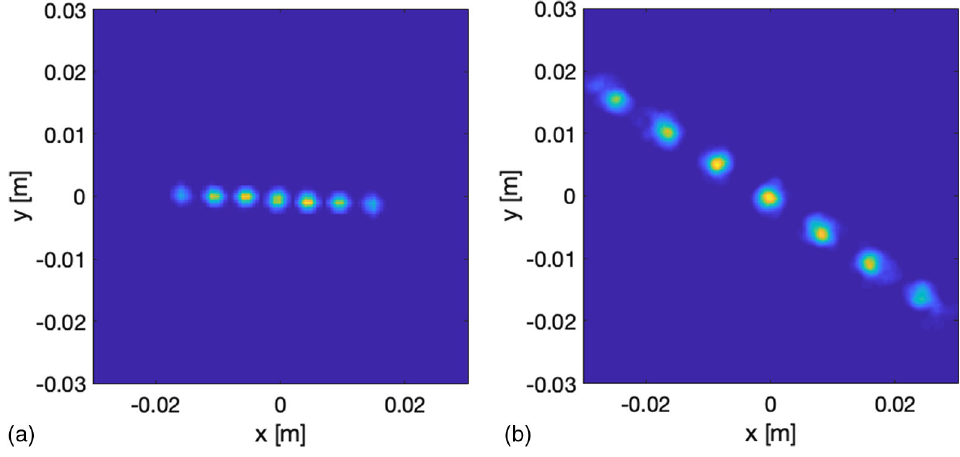
FIG. 3. Simulation (a) Initial beamlets at pepper-pot. (b) Final position of beamlets at